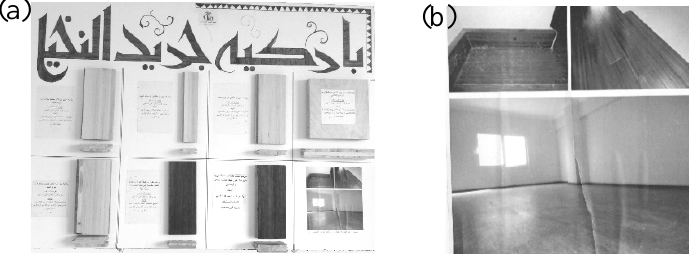
Figure 10. Photographs of (a) Palm frond parquet Flooring (b) Room with Palm frond parquet Flooring covered with a layer of beech wood Source:[Egyptian Association for self-development of local communities, Egypt, researcher